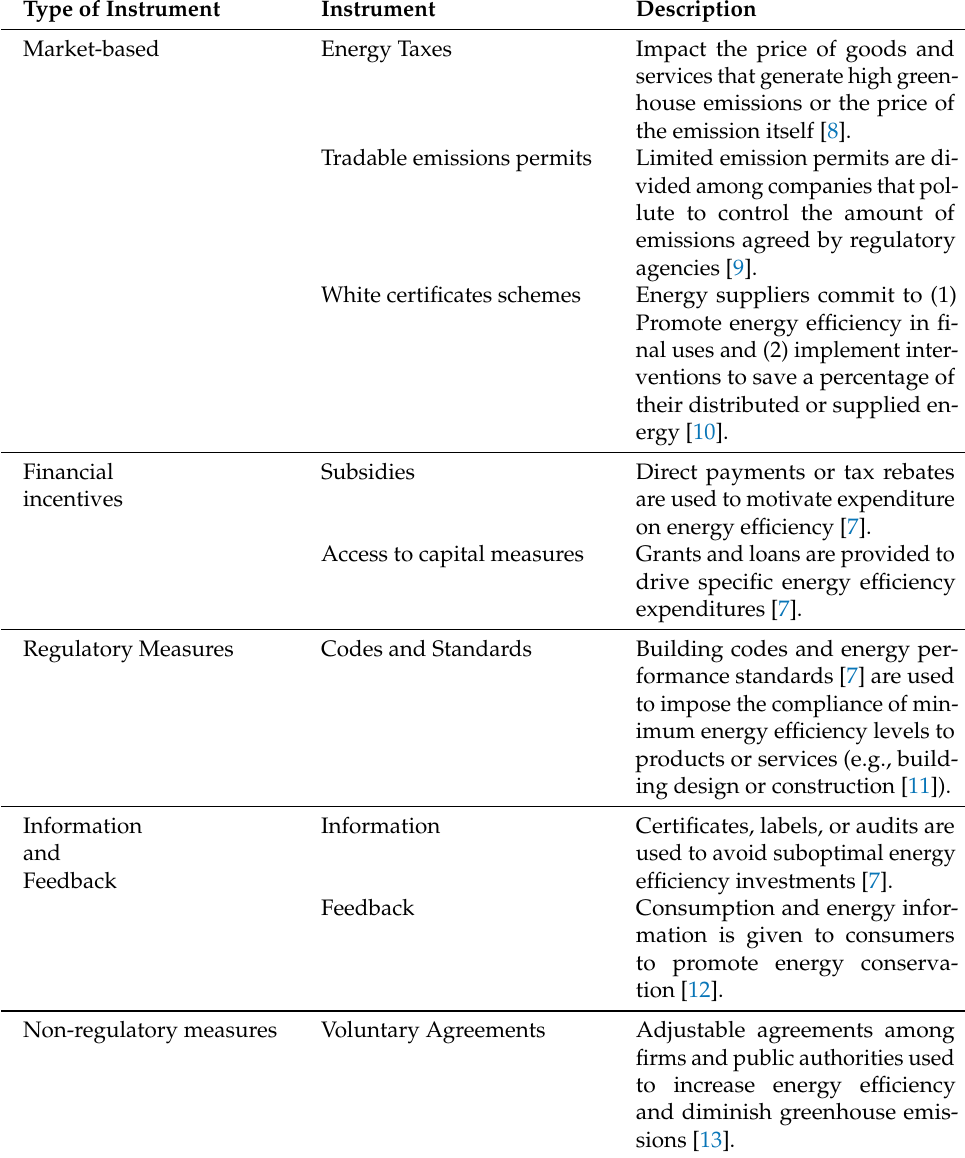
Table 1. Energy Efficiency Policy